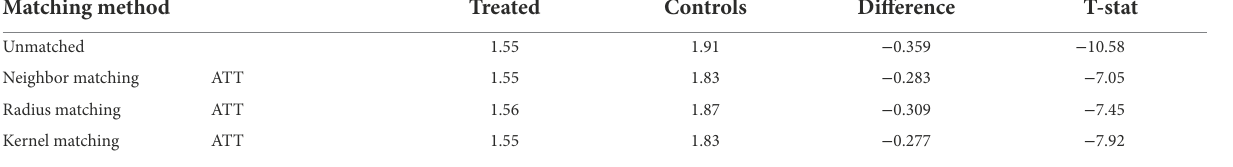
TABLE 8 Average treatment effect for PSM.